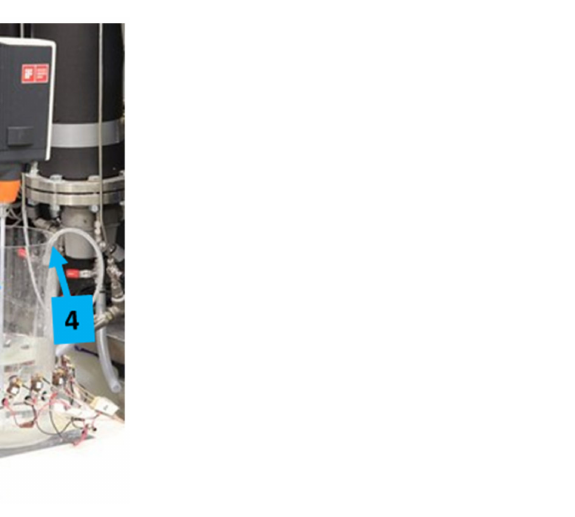
Figure 3. (1) Reactor with the ERT sensor unit mounted; (2) Rushton plastic turbine; (3) ERT device for data acquisition and process monitoring; (4) feed pipe for the reagent